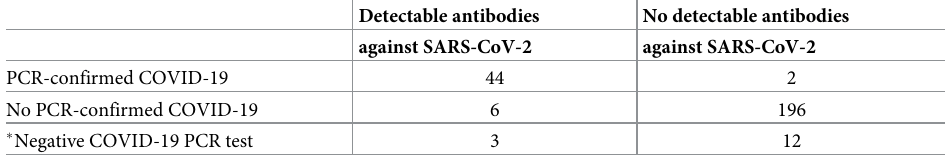
Table 1. Categorization of subjects recruited into COVID-19 serology study in NL.